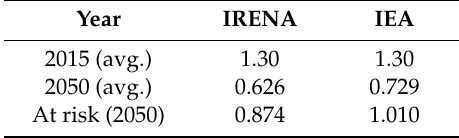
Table 5. Capital prices [USD / W].